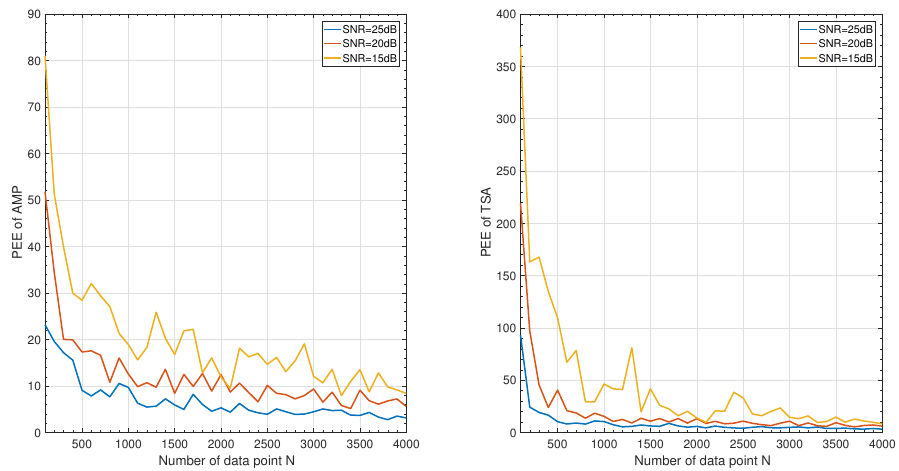
Figure 4. Averaged results of PEE for APM ( left , red line) and TSA ( right , blue line) under different N and SNRs, where N ∈ [ 100,4000 ]